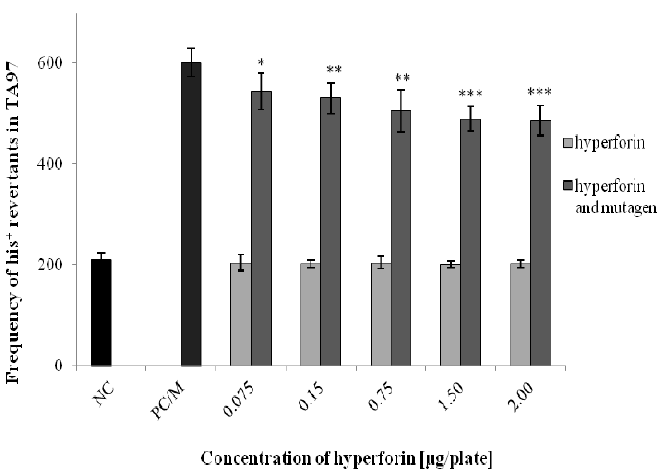
Figure 3. Determination of HF antimutagenic effects using the Ames test—strain Salmonella typhimurium TA97. Data shown are mean ± SD of three repeated experiments. NC = negative control; PC/M = positive control = mutagen = (9-aminoacridine). Comparison with positive control (PC/M): * 0.01 < p < 0.05; ** 0.001 < p < 0.01; *** p < 0.001.